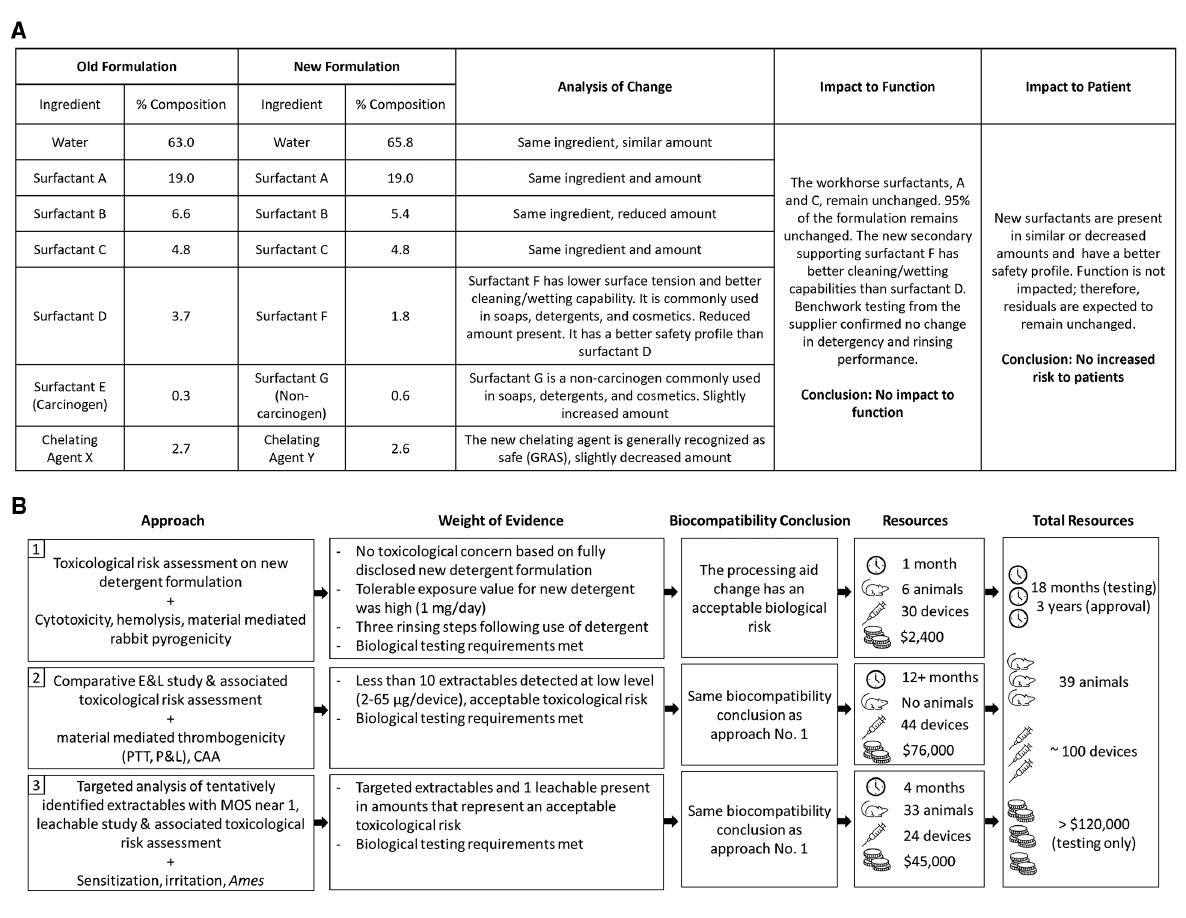
FIGURE 1 ( A ) Comparison of new and old detergent formulation and analysis of impact to function and patient risk; ( B ) path to achieving biocompatibility regulatory approval following a processing aid change used in the manufacturing of an implant medical